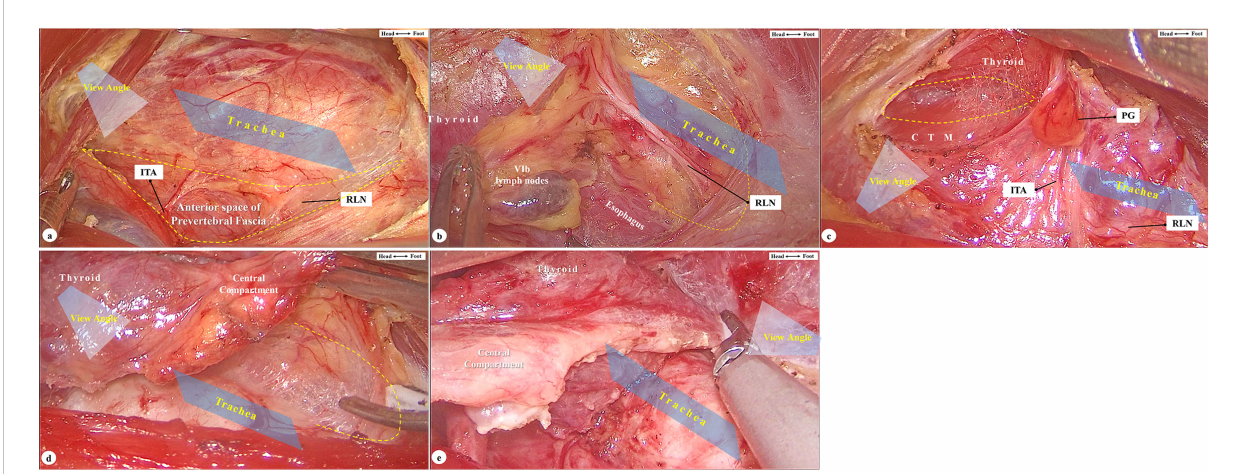
FIGURE 6 The view angle (marked in light blue), reference plane (marker in dark blue) (A) , and anatomic structures. (A) Expand the anterior space of the prevertebral fascia (circled in dotted curve) and locate the inferior thyroid artery (ITA) and recurrent laryngeal nerve (RLN). (B) Dissect the posterior and inferior (traced with dotted curve) boundary of central compartment. (C) Expand the cricothyroid space (circled in dotted curve), dissect the upper pole of the thyroid, and protect the parathyroid gland (PG) in situ. (D) Fully dissect the boundary of the thyroid and central compartment (traced with dotted curve). (E) Complete thyroidectomy and central neck